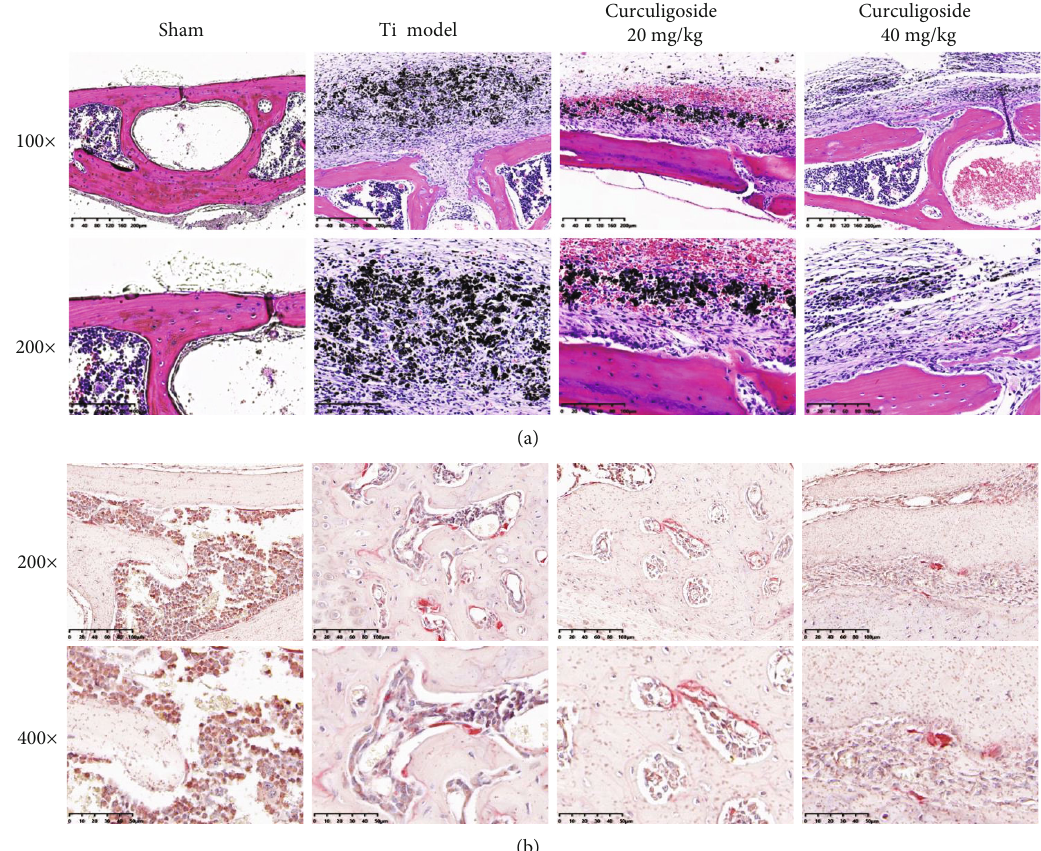
Figure 8: Curculigoside treatment attenuated Ti-induced osteolysis in histological analysis of calvaria sections: (a) HE staining; (b) TRAP staining. Ti: titanium